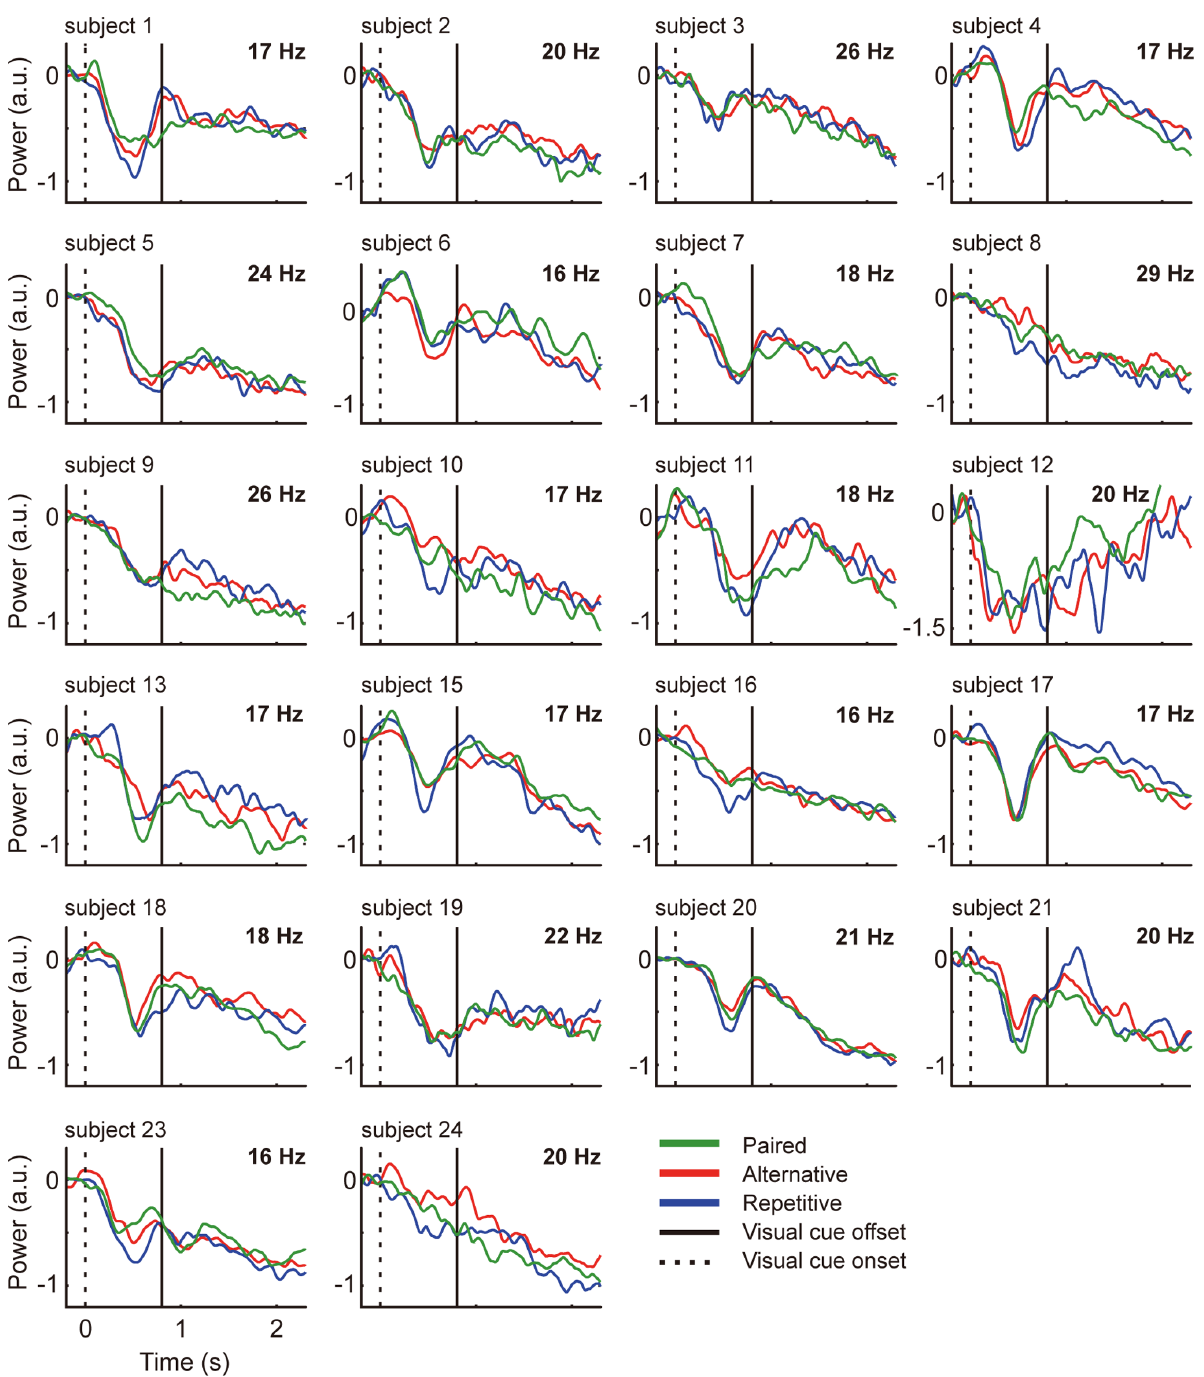
Figure 3. Beta-power time-course for 22 subjects. Vertical axis is power (arbitrary units), horizontal axis is time (second). Green line is ‘Paired’ red line is ‘Alternative’ and blue line is ‘Repetitive’. The dotted and solid vertical lines depict zero (visual cue onset) and visual cue offset (0.8 s), respectively. The frequency of the power for each subject is indicated in the upper right corner of each plot.